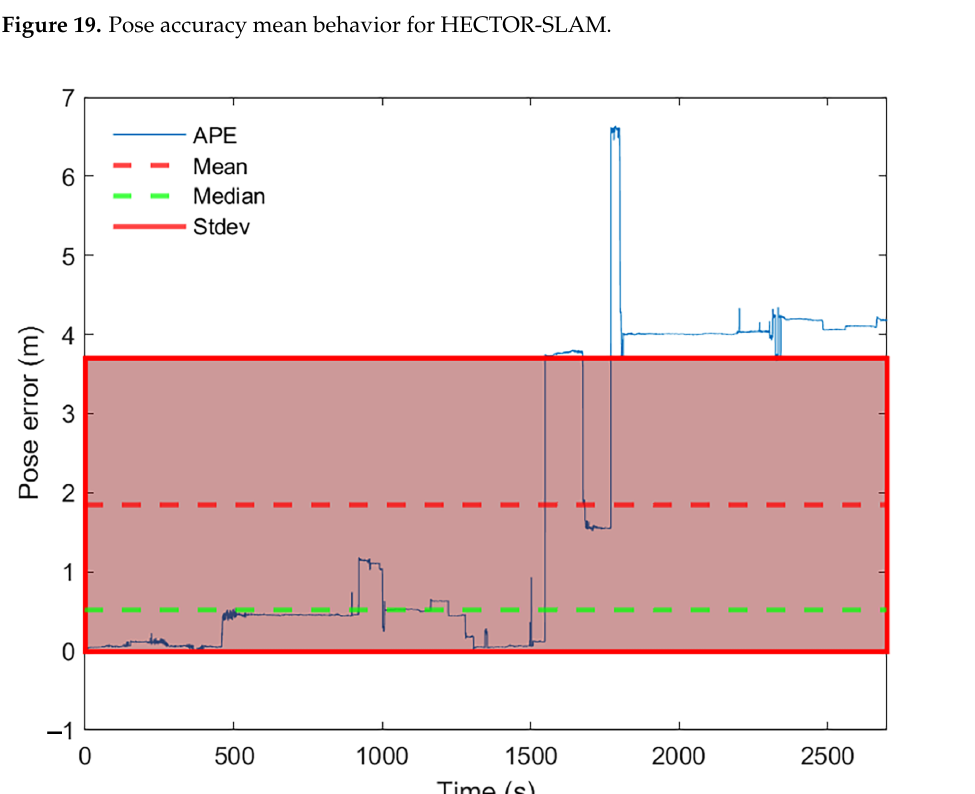
Figure 20. Pose error timeseries evolution for HECTOR-SLAM on observation